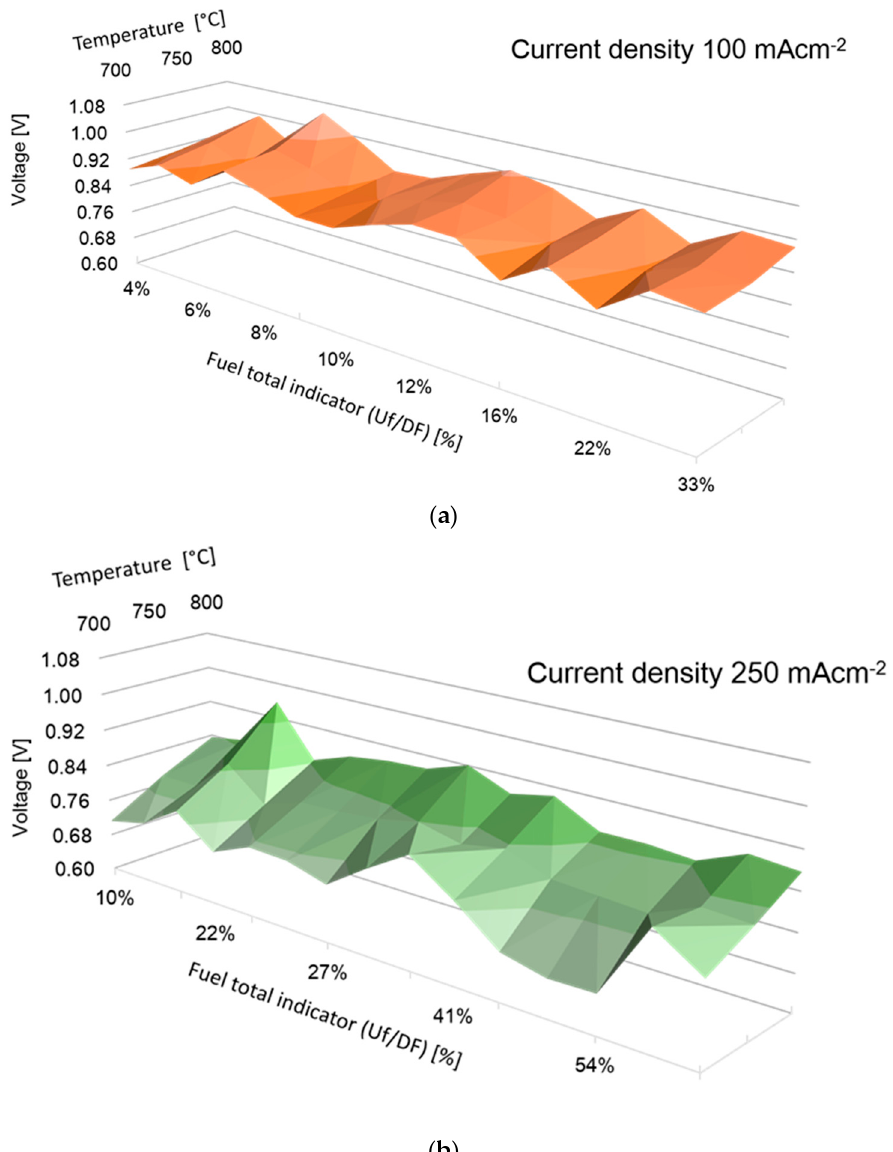
Figure 2. Performances maps at constant current load: 100 mA·cm − 2 ( a ) and 250 mA·cm − 2 ( b ).